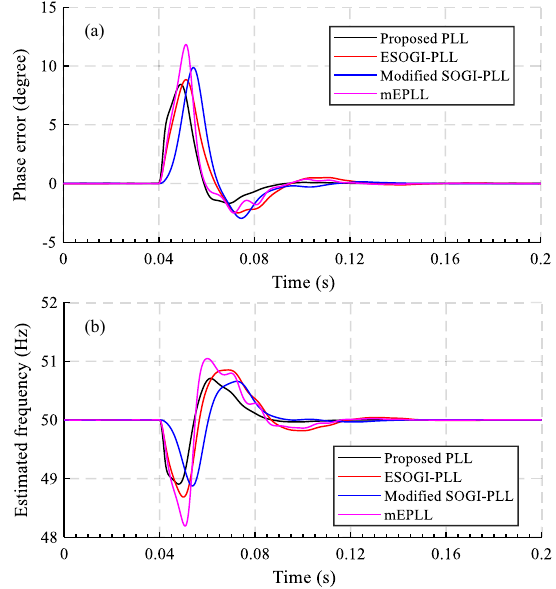
Fig. 11 Performance comparison between the proposed PLL, ESOGI-PLL, modified SOGI-PLL, and mEPLL under Case 5 (a 0.15 pu